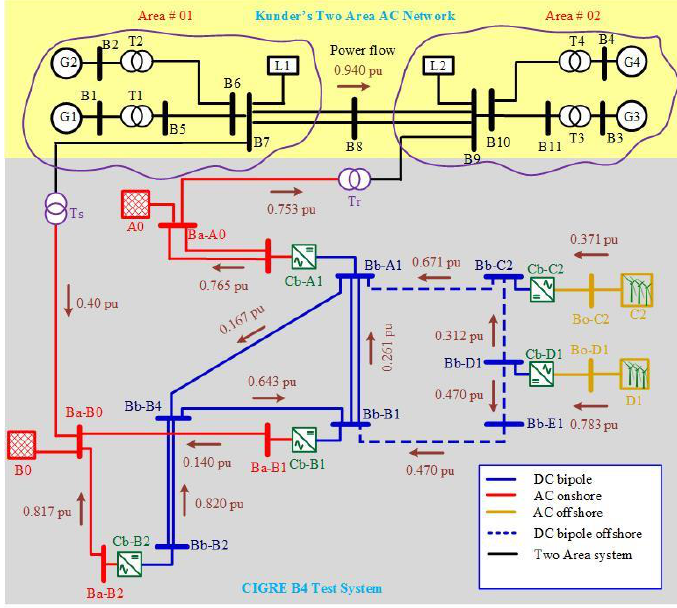
Figure 1. Interconnected AC/DC systems.